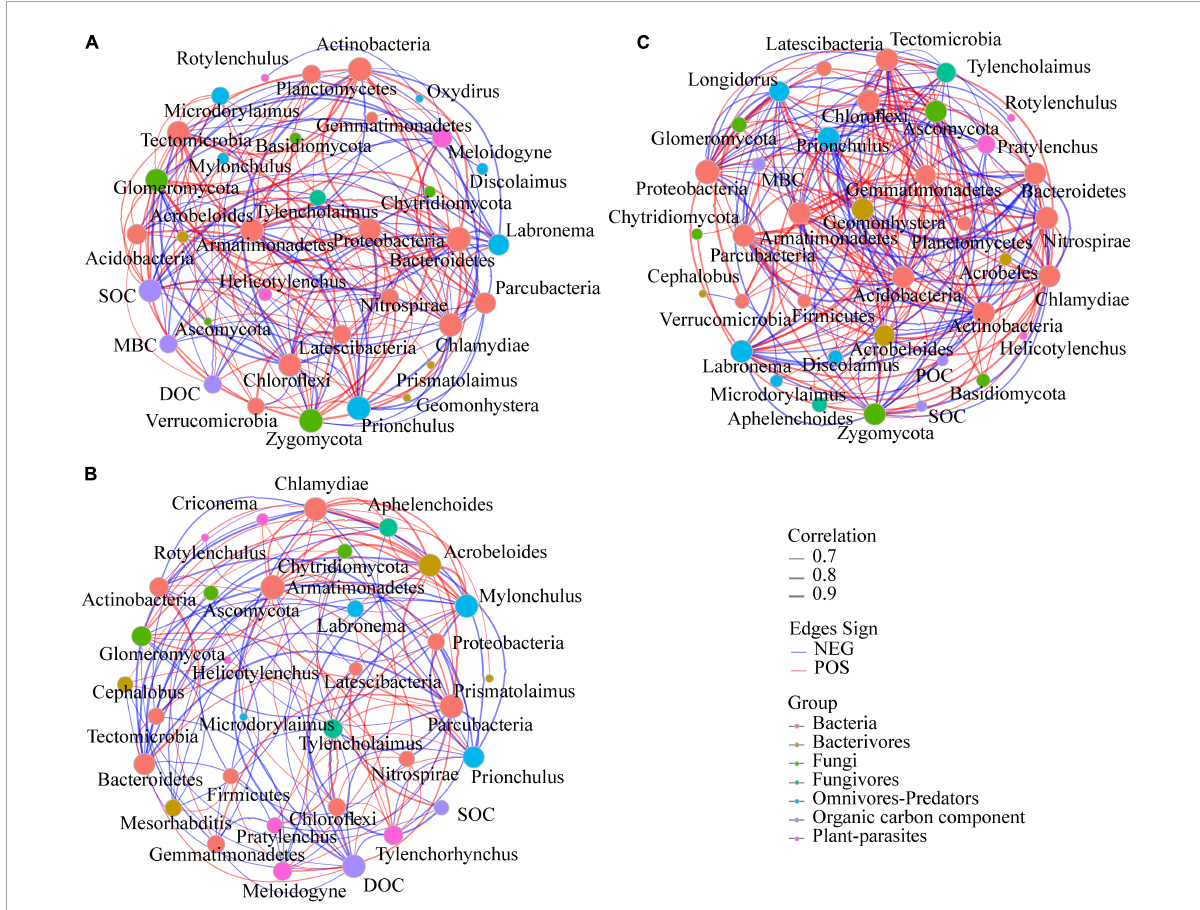
FIGURE3 Interaction networks among bacterial and fungal phyla, nematode trophic groups, and SOC components present in different fertilization treatments. A connection stands for a strong (Spearman’s rho > 0.6) and significant ( P < 0.01) correlation for the CK (A) , CF (B) , and OM (C) . For each panel, the node size is proportional to the number of node connection across all the samples and the thickness of each connection between two nodes (that is, edge) is proportional to the value of Spearman’s correlation coefficients. Lines connecting nodes (edges) represent positive (red) or negative (blue) co-occurrence relationships. CK, no fertilization; CF, chemical fertilization; OM, organic